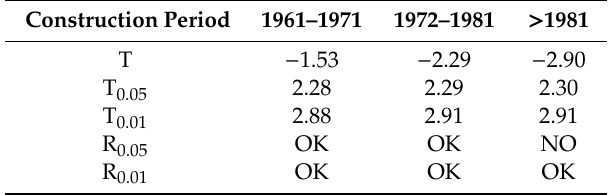
Table 3. The t -test on concrete strength values extracted from vertical members and